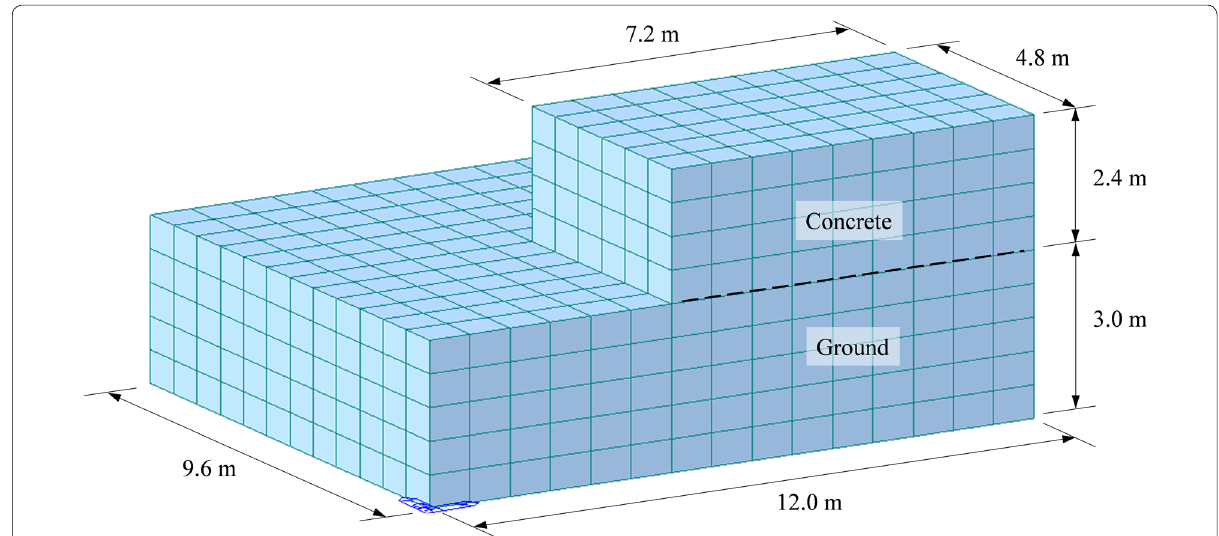
Fig. 6 Finite element mesh of the mat foundation.